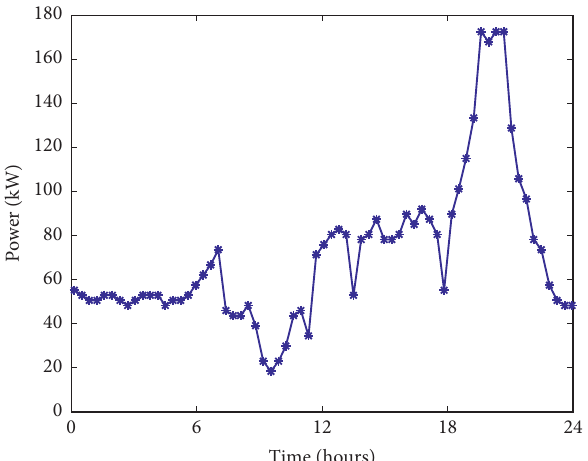
Figure 5: Baseload profile for 24 hours recorded on a peak day (24/